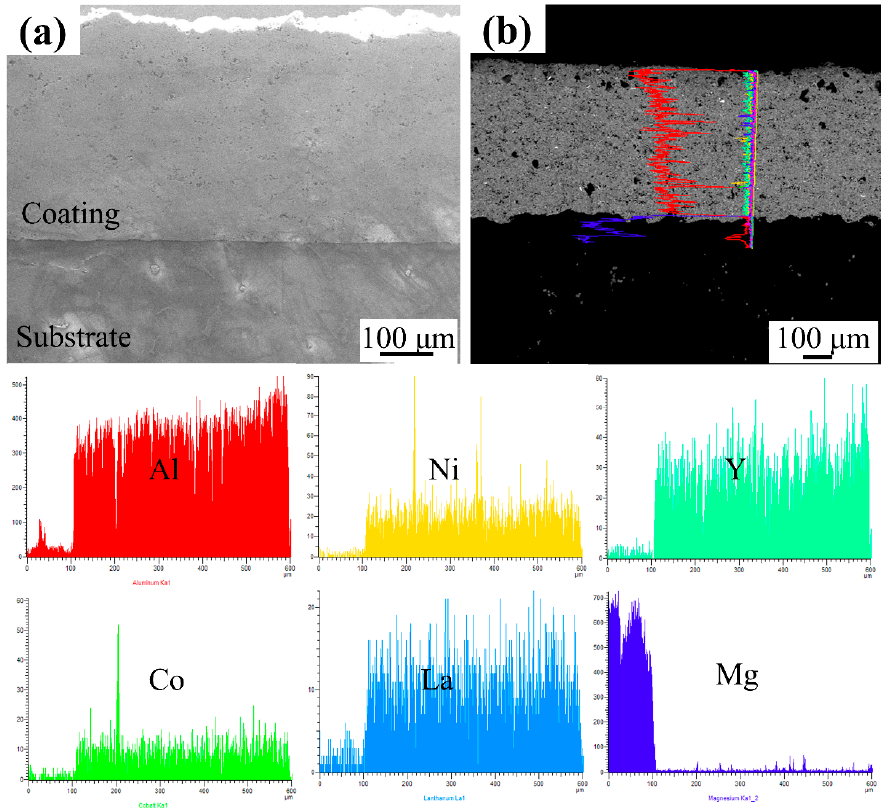
Figure 5. Surface morphology ( a ) and the energy-dispersive X-ray spectroscopy (EDS) analysis of the coating ( b ) under SEM.